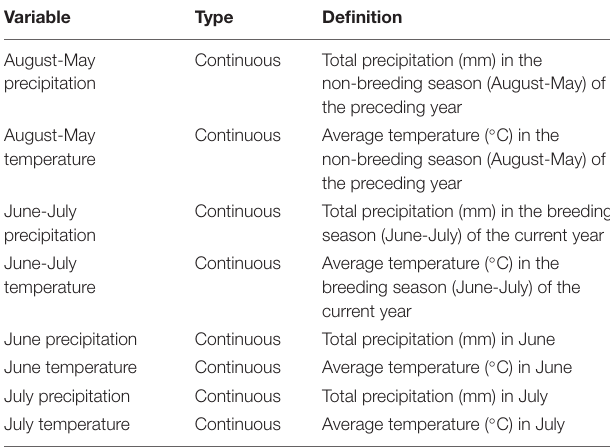
TABLE 1 | Weather parameters.